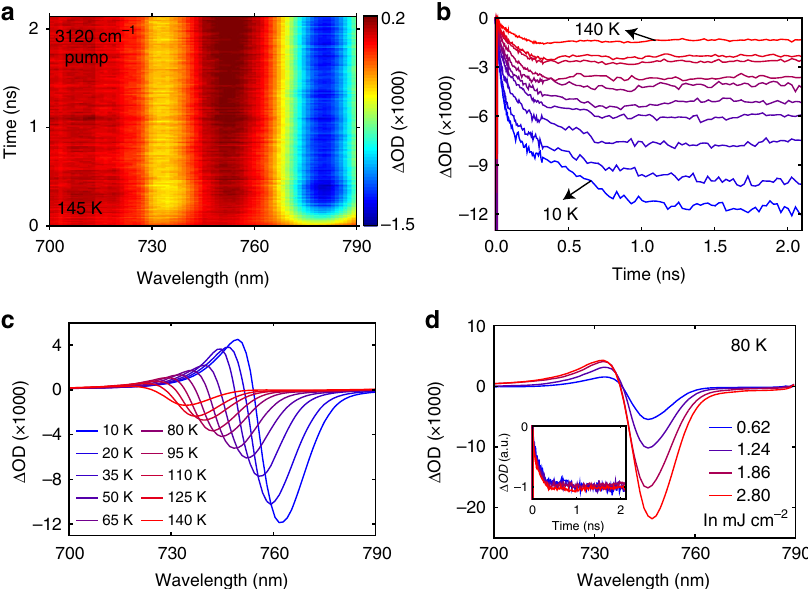
Fig. 2 Temperature- and fl uence-dependent transient optical response. a Δ OD spectral map measured at 145K with on-resonance infrared pump. b Transient kinetics at the wavelength that shows the strongest bleach signal (indicated by the dashed line in Fig. 1c), measured at different temperatures. c Transient spectra at 2ns delay time measured at different temperatures. Legend in ( c ) applies to ( b ) as well. Pump fl uence used in ( b , c ) was 0.45 mJ cm − 2 . d Fluence-dependent transient optical spectra at 2ns delay time; inset: kinetics for different fl uences appear nearly